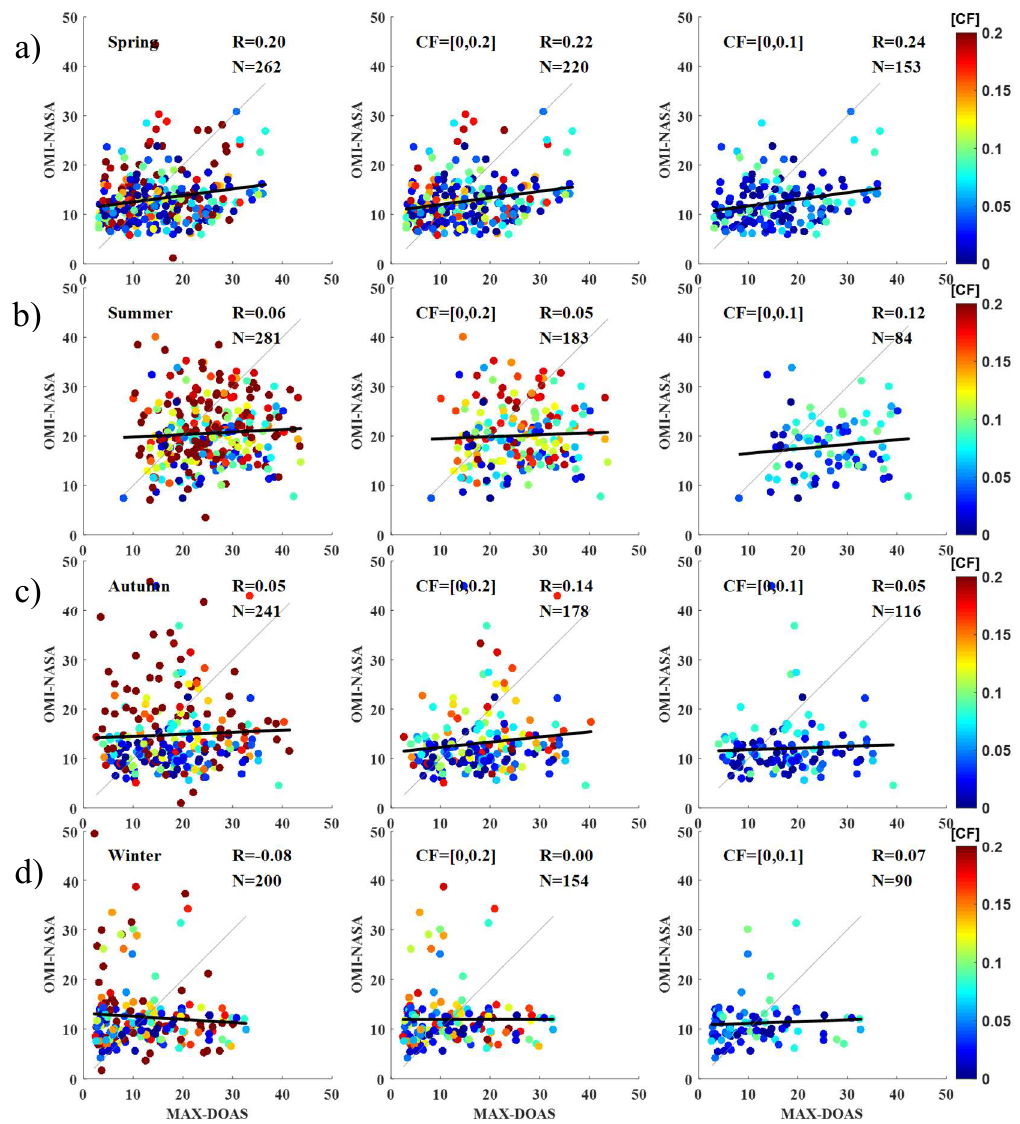
Figure A2. Daily comparisons of OMI-NASA and MAX-DOAS; left panels: 0 ≤ eCF ≤ 30%, middle panels: 0 ≤ eCF ≤ 20%, right panels: 0 ≤ eCF ≤ 10%. ( a ) Spring (MAM), ( b ) Summer (JJA), ( c ) Autumn (SON), ( d ) Winter (DJF).